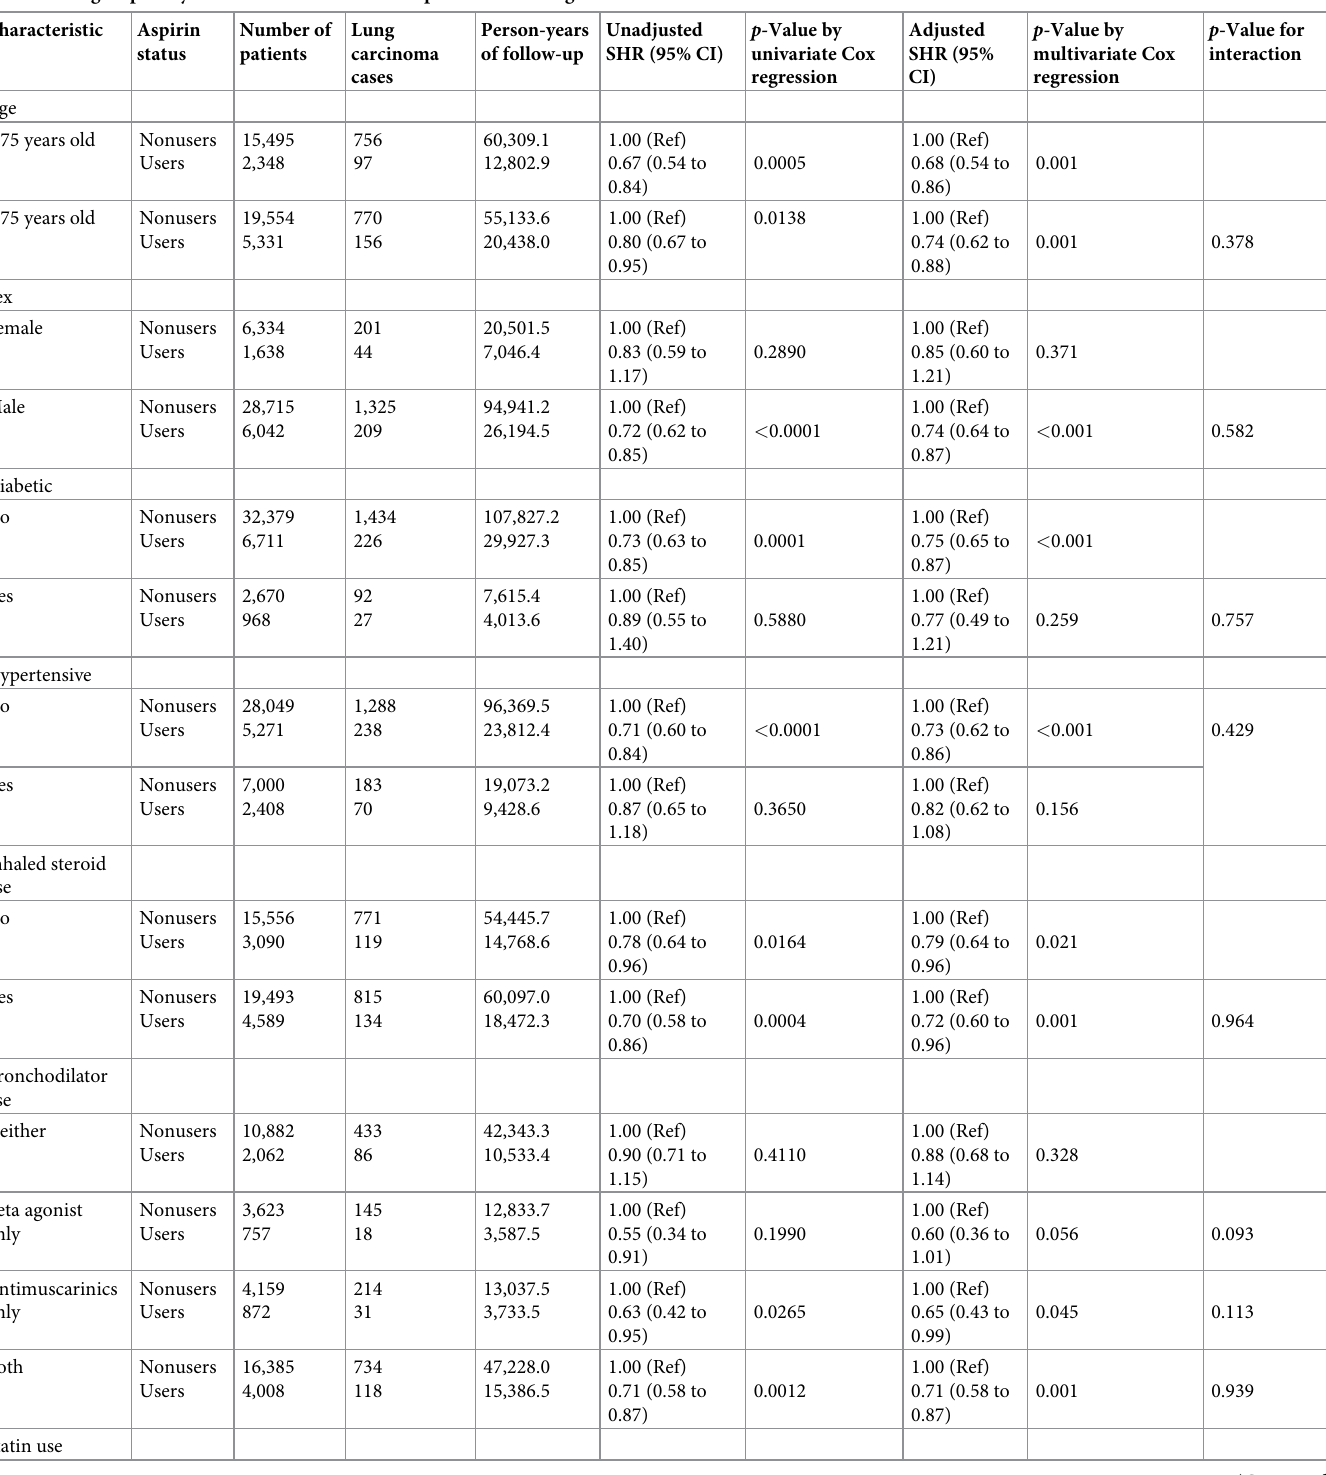
Table 4. Subgroup analyses of association between aspirin use and lung carcinoma